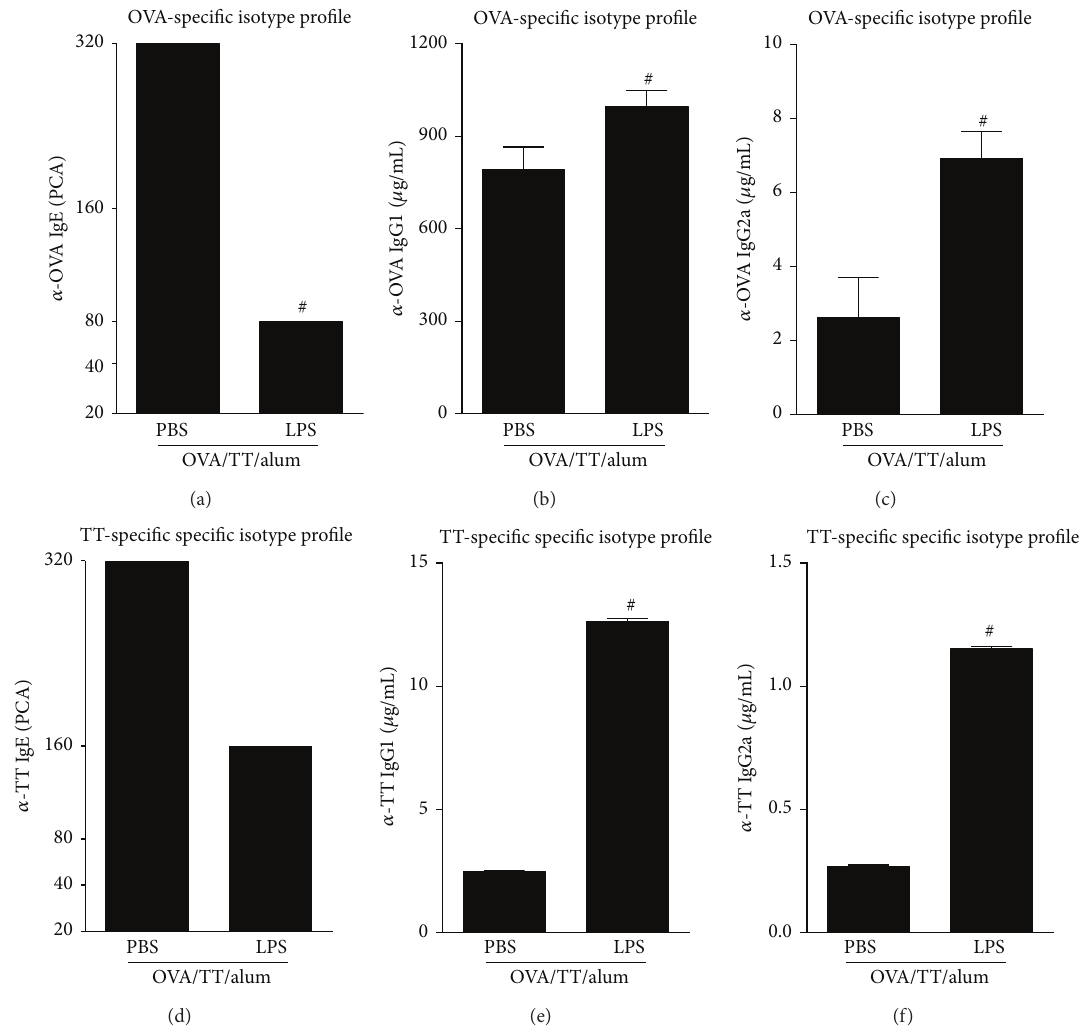
Figure 5: Effects of adsorption of LPS onto OVA/TT/alum sensitization on OVA- or TT-induced isotype production. Protocol shown in Figure 4(a). ((a) and (c)) Concentration of OVA-specific isotypes: (a) PCA titers anaphylactic IgE, (b) IgG1, and (c) IgG2a. ((d) and (f)) Concentration of TT-specific isotypes: (d) PCA levels of anaphylactic IgE, (e) IgG1, and (c) IgG2a. Data shown as mean ± SE, one-way ANOVA: # 𝑃 < 0.05 ; different from OVA/TT/alum/PBS group ( 𝑛 = 5 ), and experiment was repeated